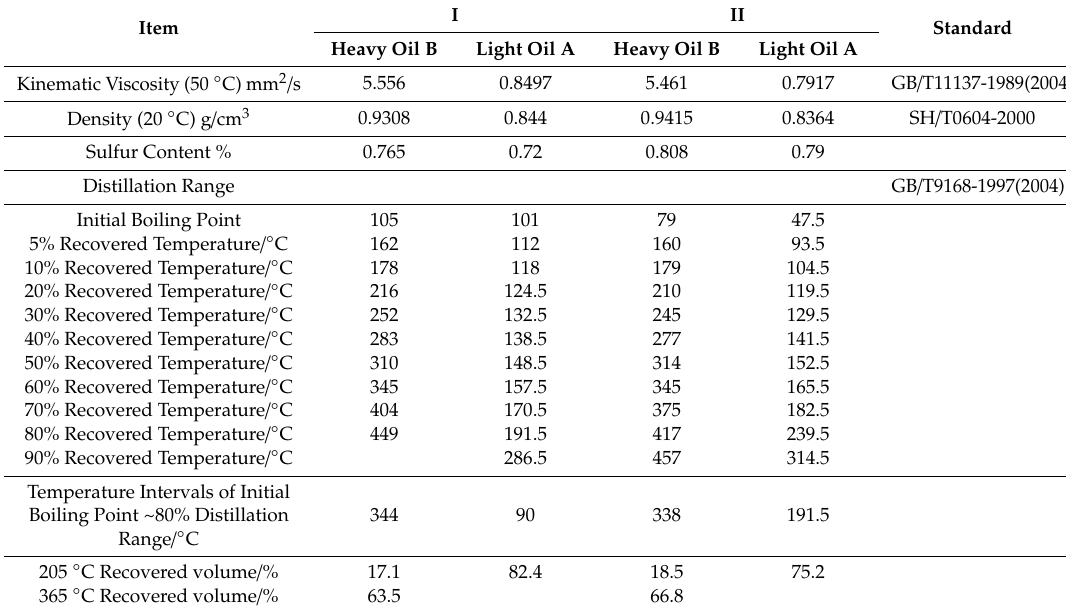
Table 4. Pyrolysis oil related